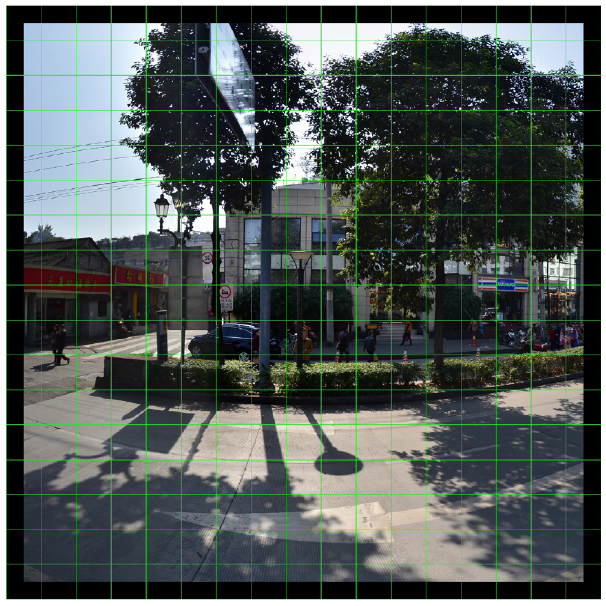
Fig. 3 Production of 256 blocks. The black frame is padding of 64 pixels. Since there are overlaps, each 2 × 2 green frame surrounds a block. The area of a block is just 1 / 64 of the original input, which greatly increases the proportion of traffic sign instances and cuts down the difficulty for later stages, since the blocks can be rescaled to 600 × 600 or even